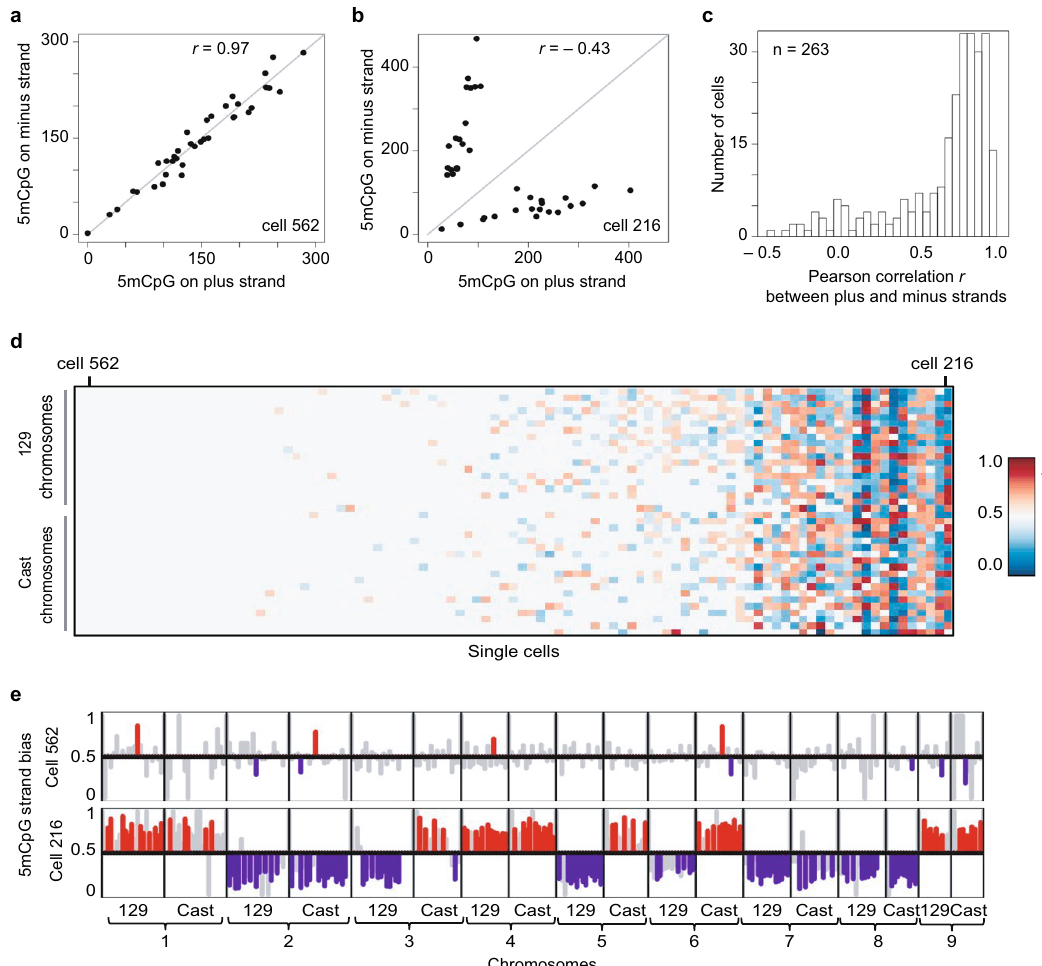
Fig. 2 Cell-to-cell heterogeneity in genome-wide strand-speci fi c methylome landscapes in mES cells. a An example of a mES cell (cell #562) processed by scMspJI-seq shows similar amounts of 5mCpG on both the plus and minus strand of each chromosome. b Another mES cell (cell #216) with asymmetric amounts of 5mCpG between the plus and minus strands of each chromosome. c Histogram of Pearson correlations between the 5mCpG levels on the plus and minus stands over all chromosomes in a cell show that while a majority of cells have similar amounts of 5mCpG on both strands (high Pearson correlation), a small fraction of cells display unequal levels of 5mCpG between the two strands of each chromosome (low Pearson correlation). d Ordered heatmap showing 5mCpG strand bias per chromosome for the maternal and paternal alleles in individual mES cells. e 5mCpG strand bias of cell #526 (top) and cell #216 (bottom) for 10 Mb bins along the fi rst 9 chromosomes are shown with statistically signi fi cant ( P < 0.05, likelihood ratio test) strand biases towards the plus and minus strands shown in red and blue, respectively. Strand biases of bins that are not statistically signi fi cant are shown in gray ( P > 0.05, likelihood ratio